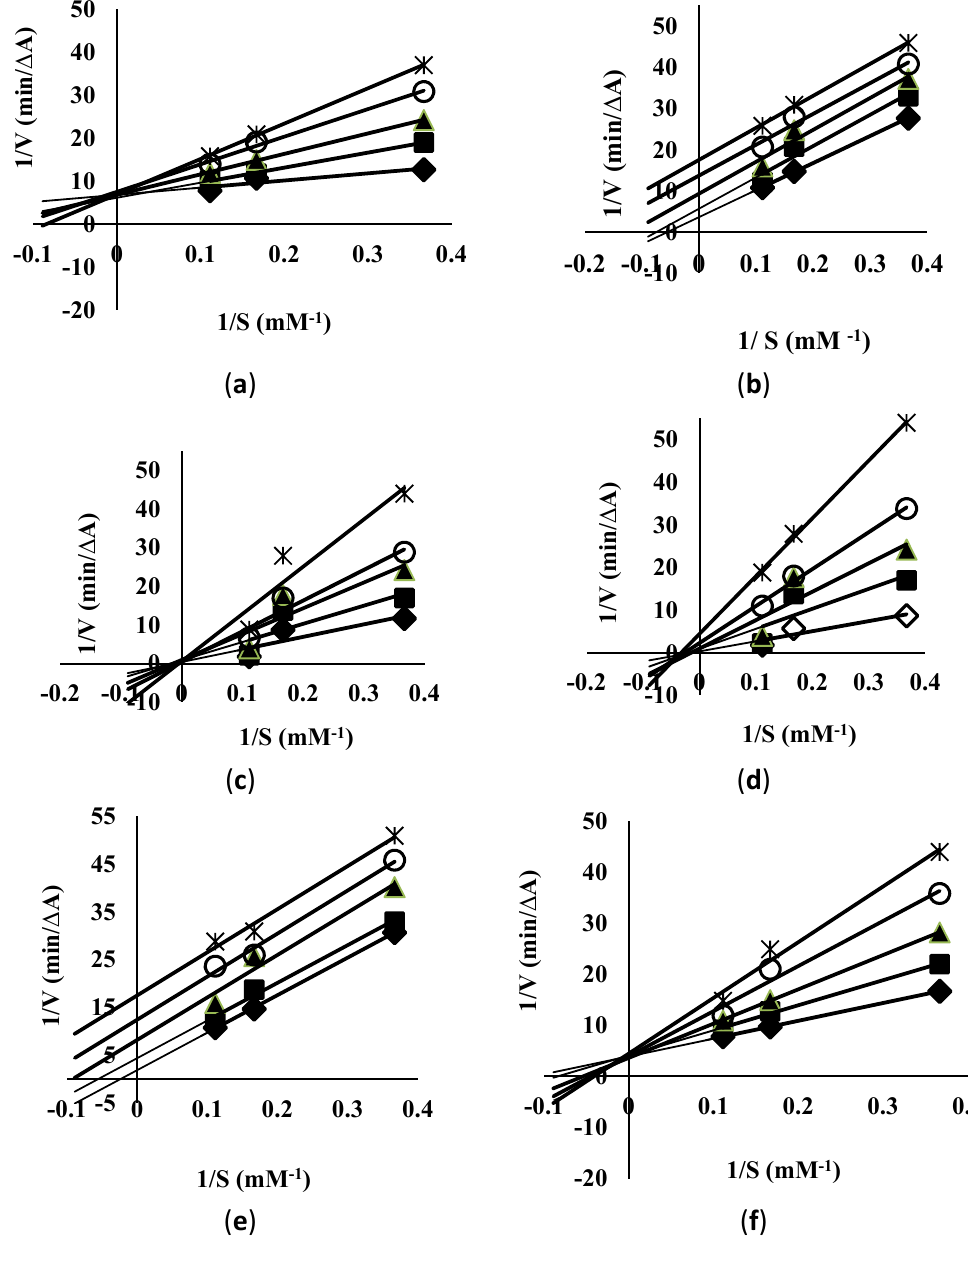
Figure 2. Inhibition of H. pylori urease by ( a ) L3; ( b ) L4; ( c ) L5; ( d ) M3; ( e ) M4; ( f ) M5; Lineweaver-Burk plots of the reciprocal of initial velocities vs reciprocal of four fixed substrate concentrations in absence ( ♦ ); presence of 80 mM (*); 60 mM ( ○ ); 40 mM ( ▲ ); 20 mM( ■ )of the